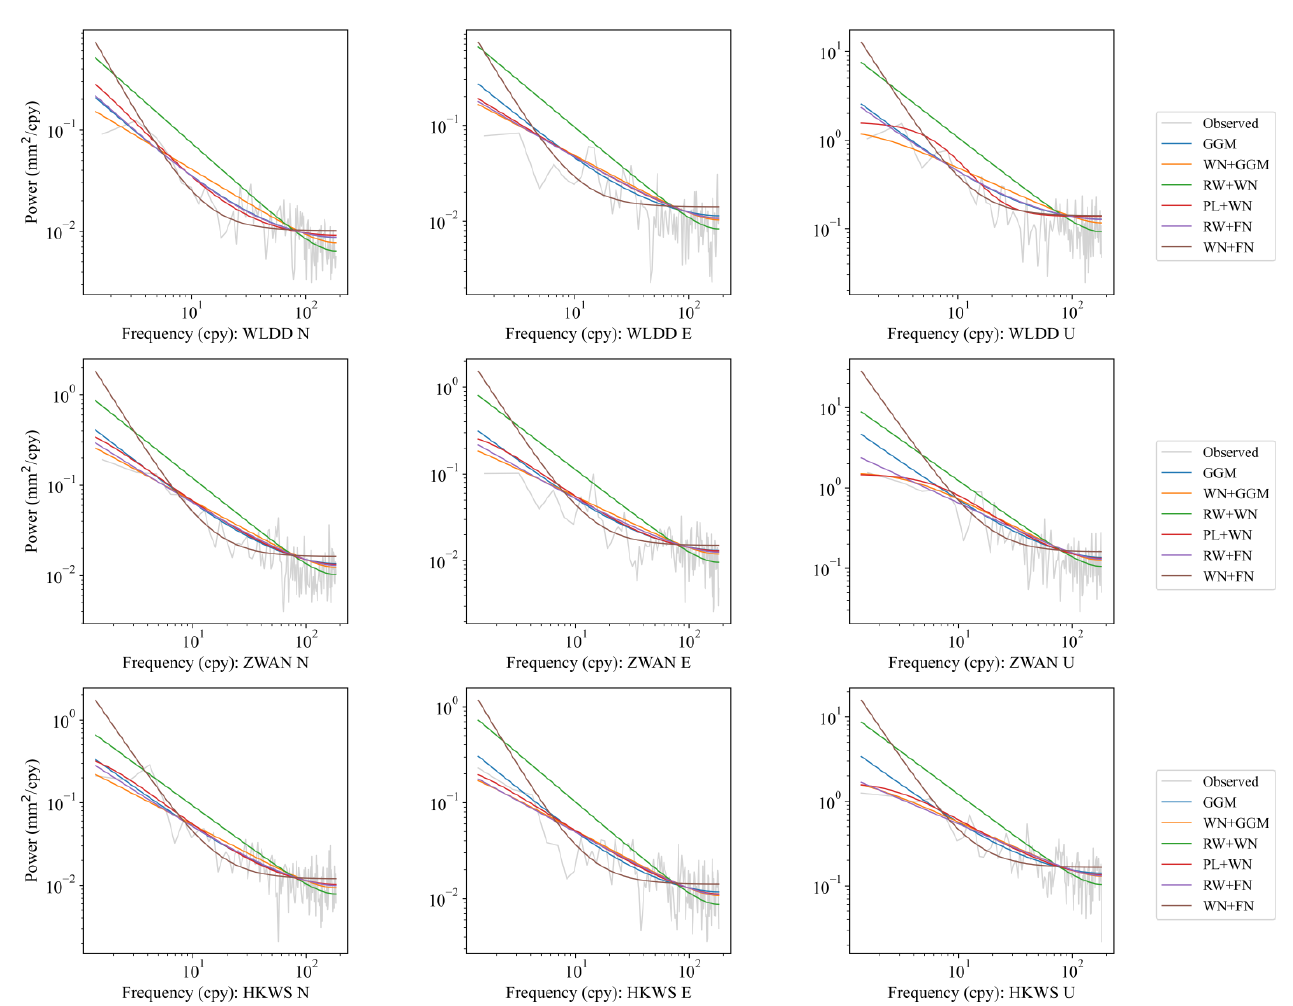
Figure 6. PSD of the time series residuals of WLDD ( top ), ZWAN ( middle ), and HKWS ( bottom